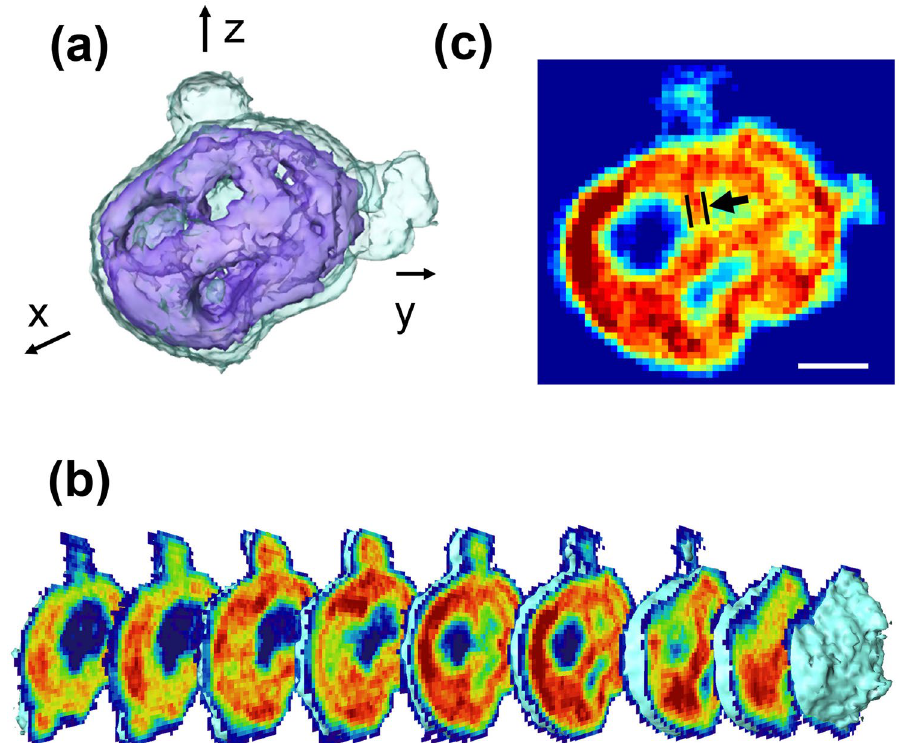
Figure 3. ( a ) 3D rendering of the mitochondrial morphology. ( b ) Sectioned images of the 3D mitochondrion tomogram cut in the y-z plane obtained at 109 nm intervals that illustrate the progressive change of the internal structure. ( c ) One of the sectioned images shown in ( b ) exhibiting internal structures well. The arrow indicates the width of a structure stemming from the exterior region, which is about 100 nm. The scale bar is 400